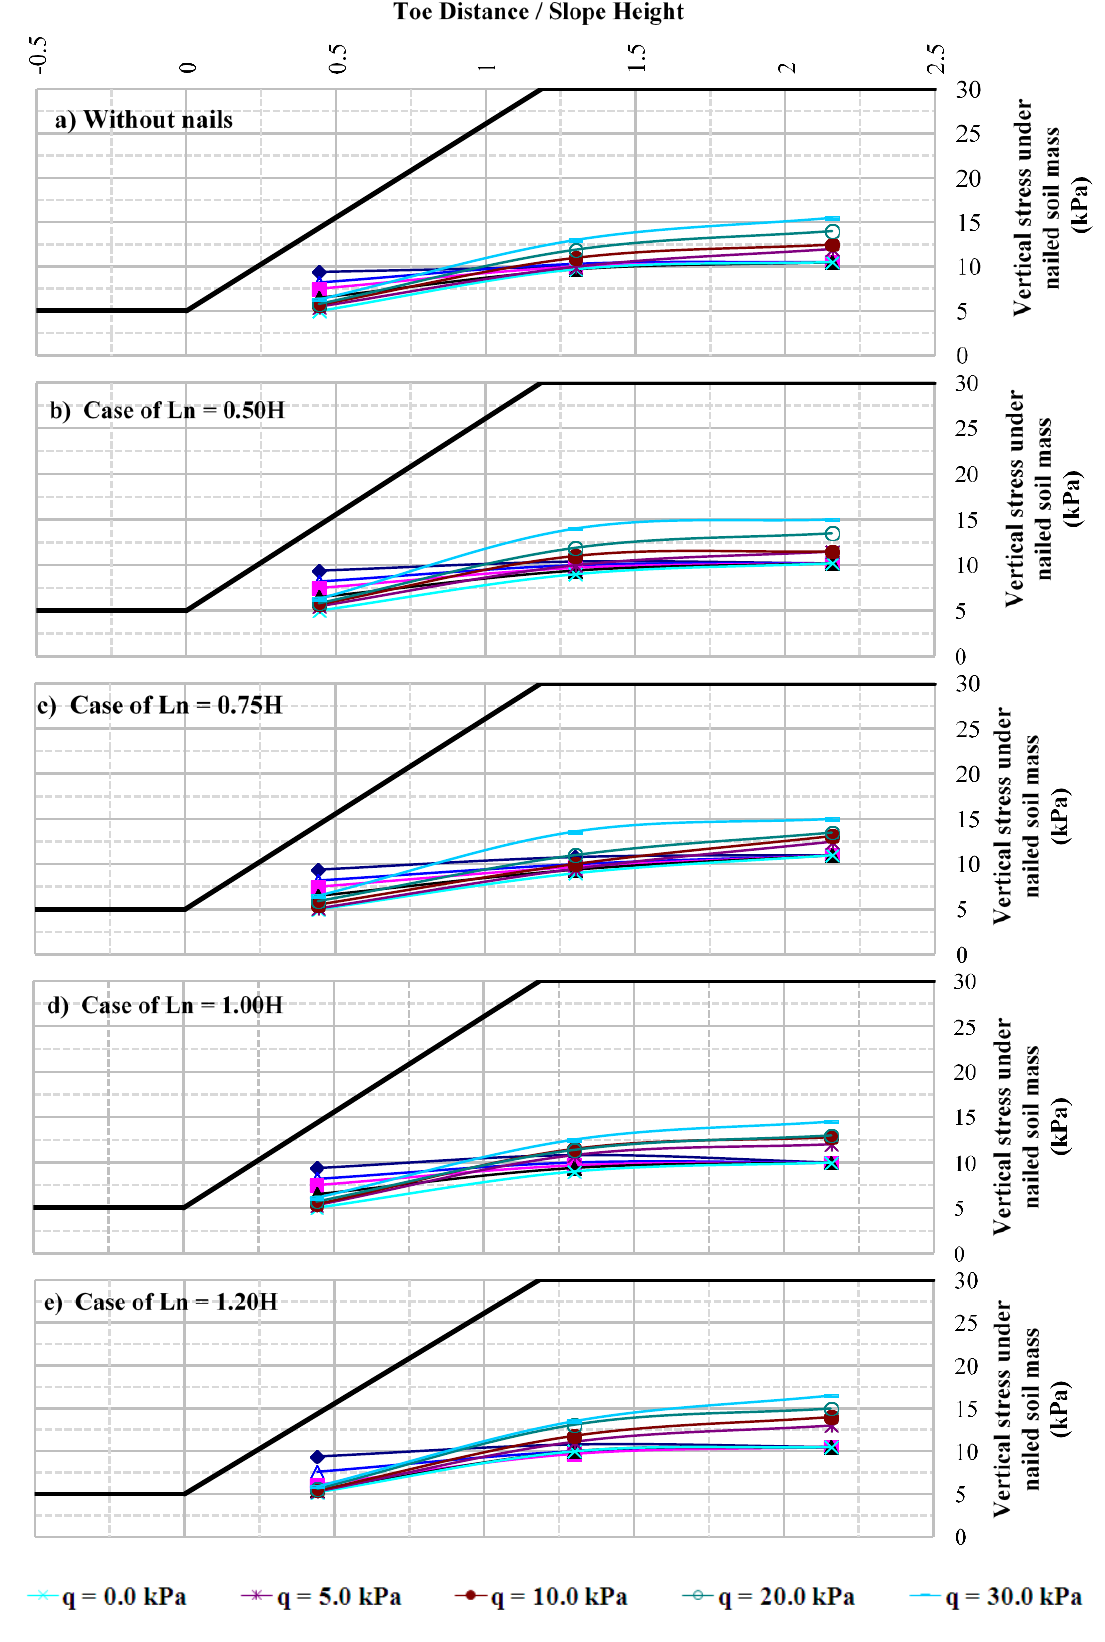
Figure 12. Distribution of vertical stresses under the soil mass at different nail length.